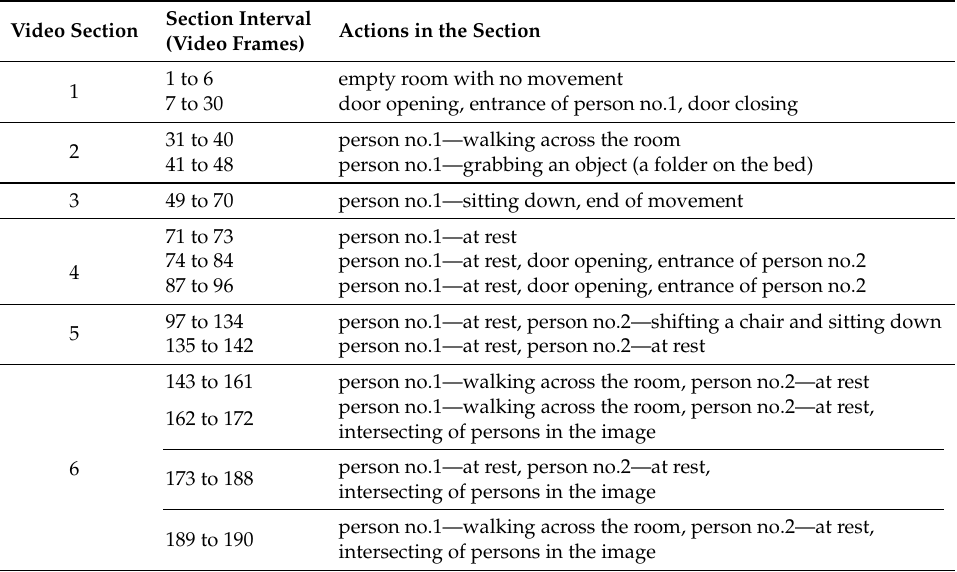
Table 2. Description of test video analysis